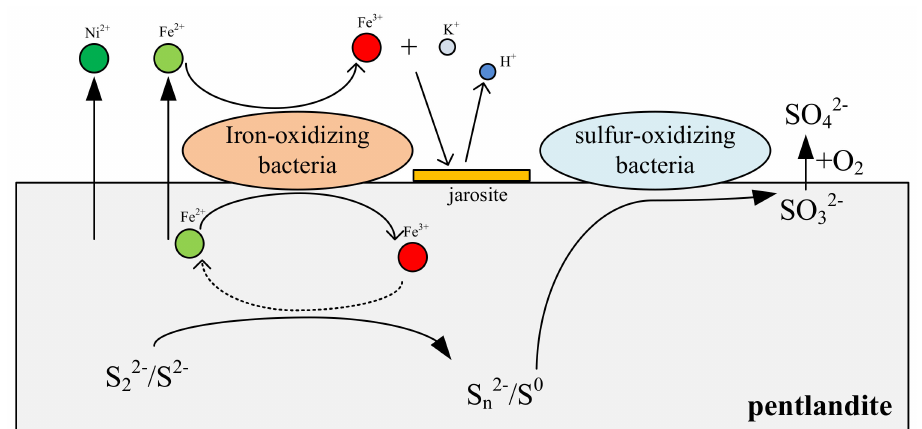
Figure 18. Conceptual model for the oxidation and decomposition of pentlandite during bioleaching with iron- and sulfur-oxidizing